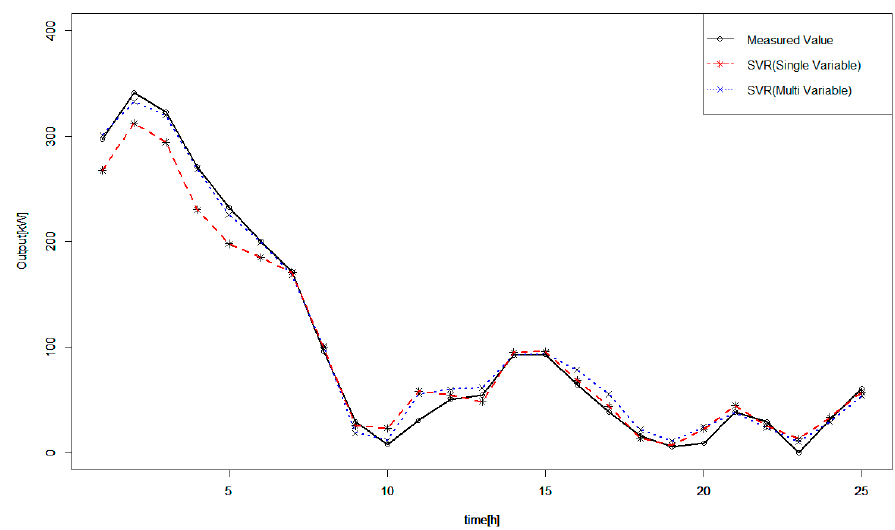
Figure 5. Measured and forecasted wind power outputs on 8 January 2016.